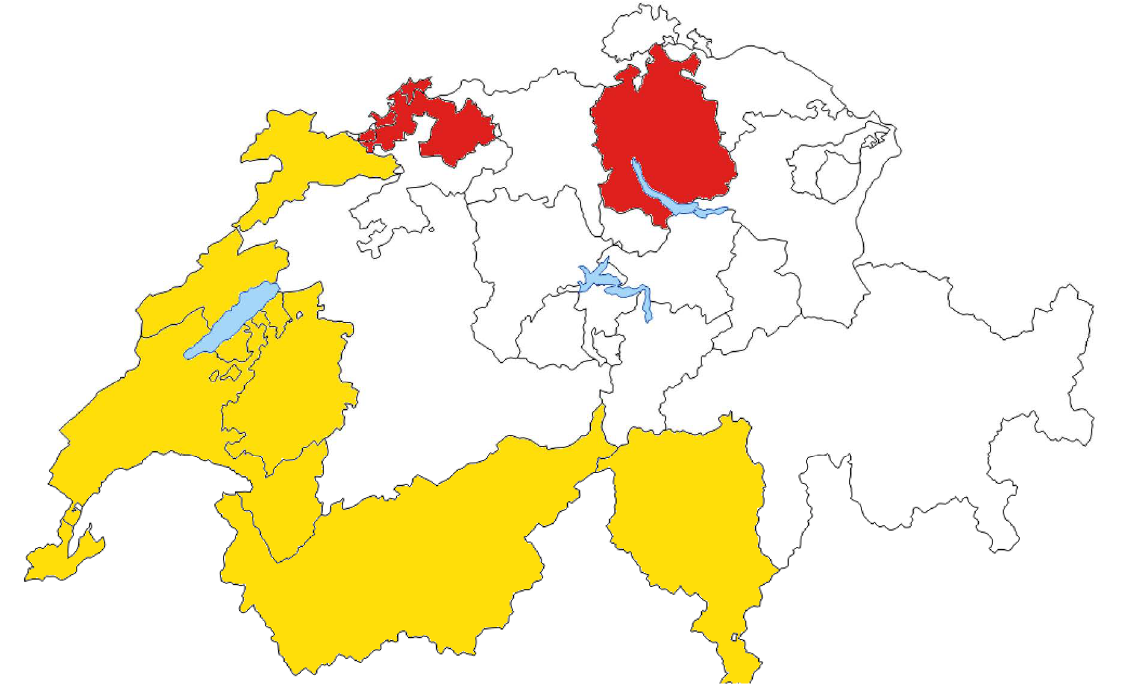
Figure 1. Swiss regions (cantons) participating in the study. Swiss-Latin cantons, including Swiss- Italian and Swiss-French, are depicted in yellow. Swiss-German cantons are depicted in red.